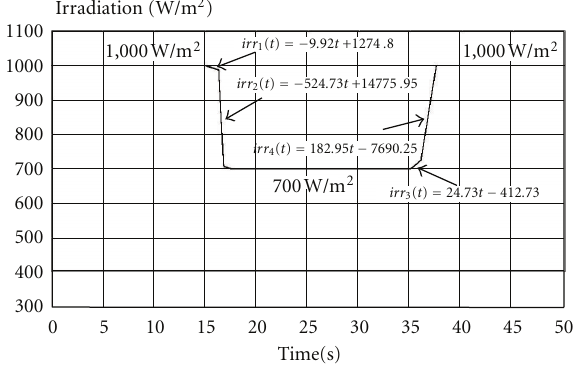
Figure 7: Simulation waveform of irradiation that dropped from 1,000 W/m 2 to 700 W /m 2 and then increased back up to 1,000 W/m 2 .